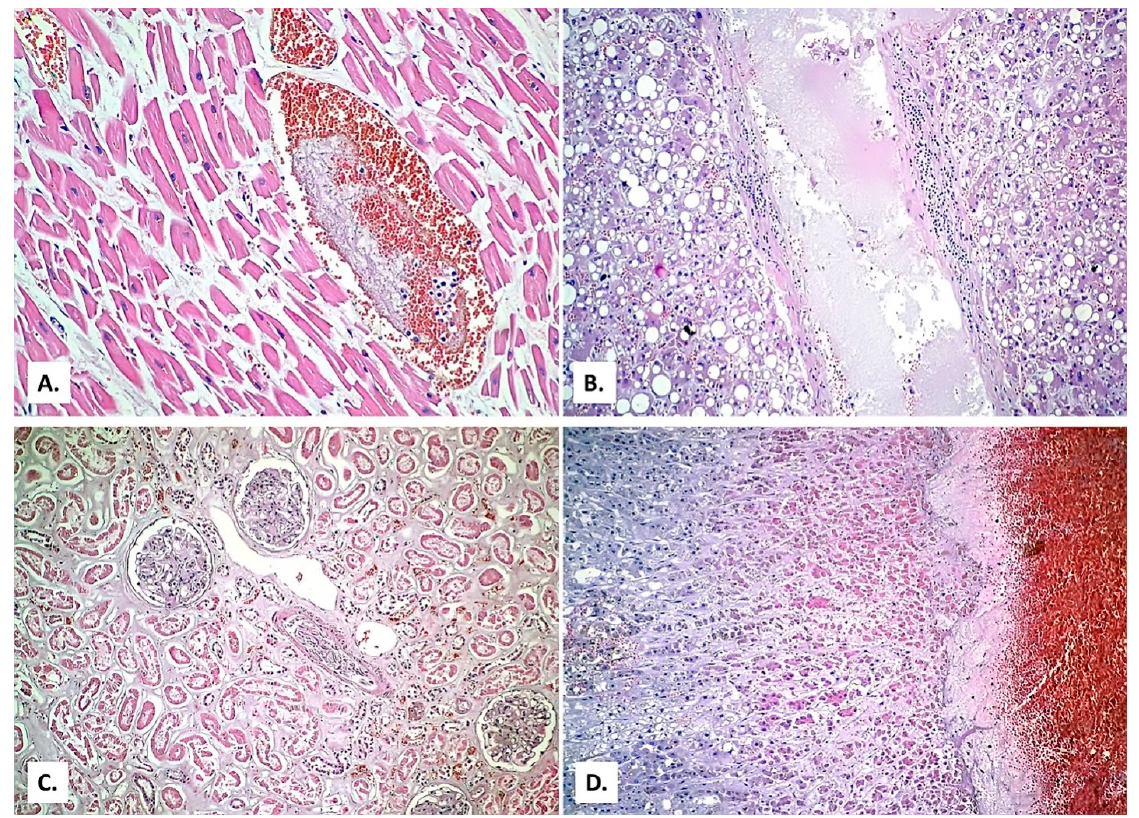
Figure 13. ( A ) Hypertrophic and fragmented myocardial fibers with a microthrombus in a venous vessel (HE × 400). ( B ) Liver with severe alcoholic steatosis and inflammation of the suprahepatic vein wall (HE × 100). ( C ) Kidney with tubular necrosis (HE × 200). ( D ) Adrenal medullary hemorrhage (HE × 40).